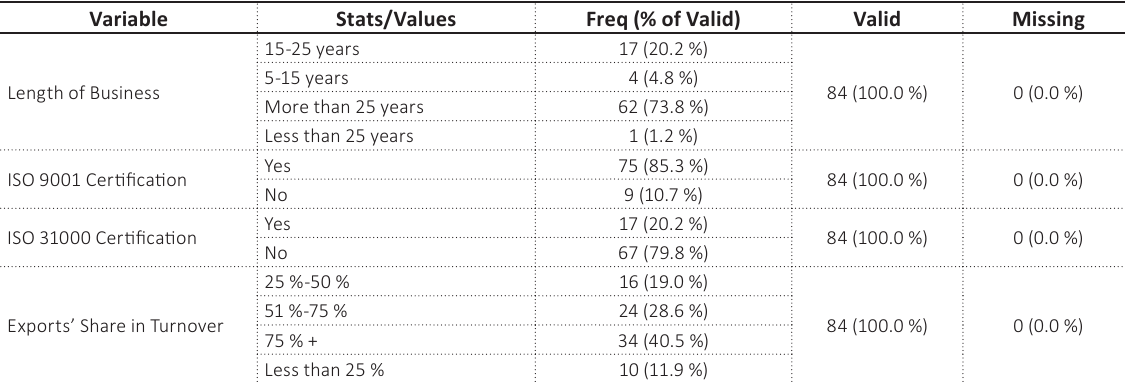
Table 1. Essential characteristics of surveyed enterprises